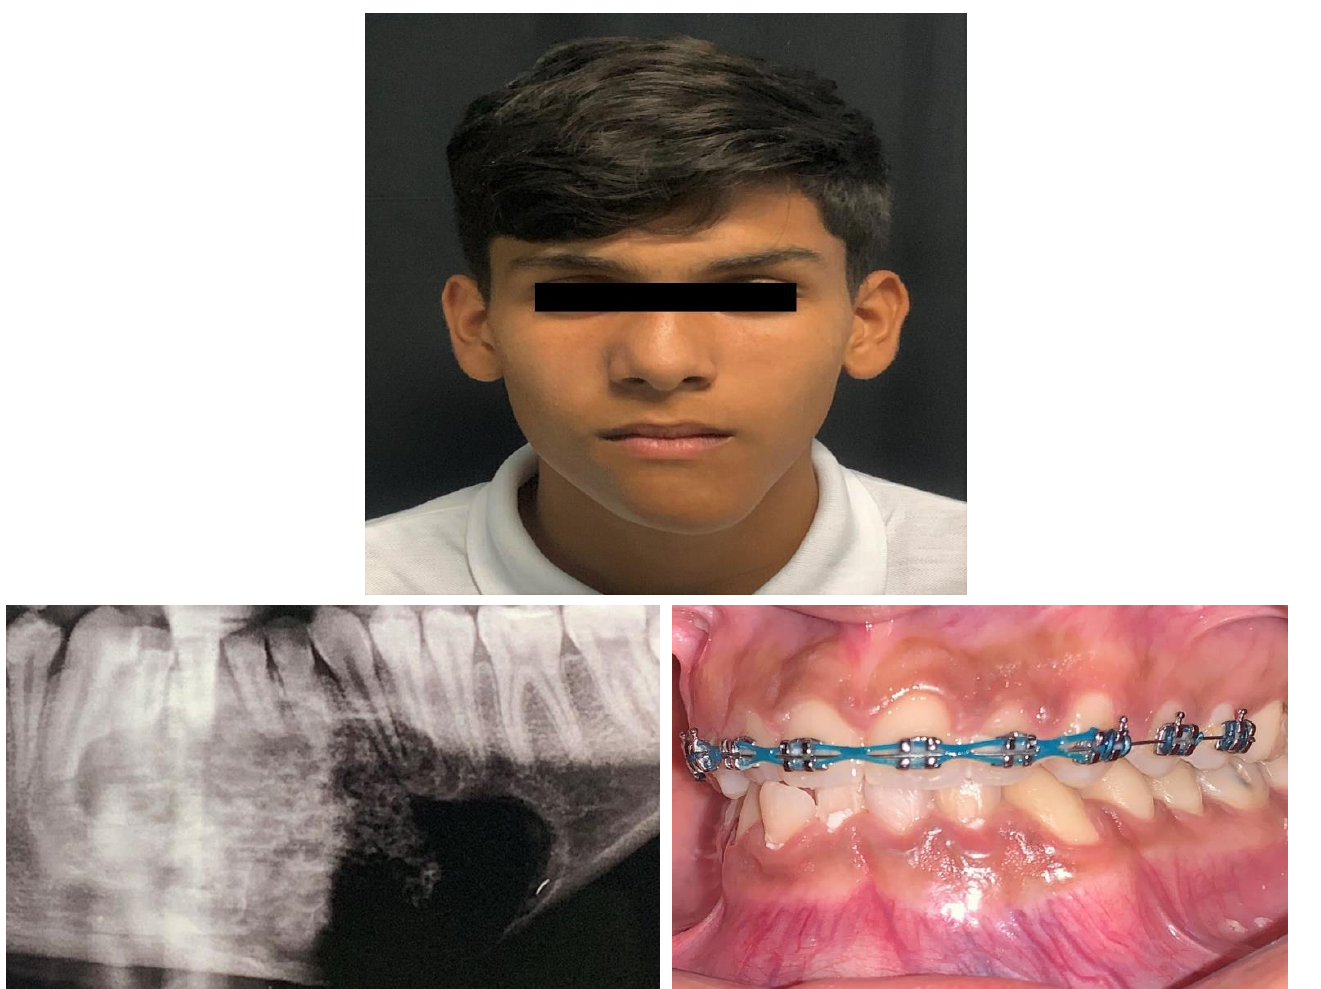
Fig. 1. (A) Extraoral photograph showing facial asymmetry. (B) Intraoral photograph showing buccal cortical plate expansion. (C) Panoramic radiography showing a radiolucent lesion in the anterior region of the mandible. Computed tomography (CT) scan showed a unilocular isodense were perforated (Fig. 2). Differential diagnoses included central ossifying intraosseous mass, delimited by a hyperdense border with multiple hyperdense particles inside the lesion. The buccal and lingual bone plates